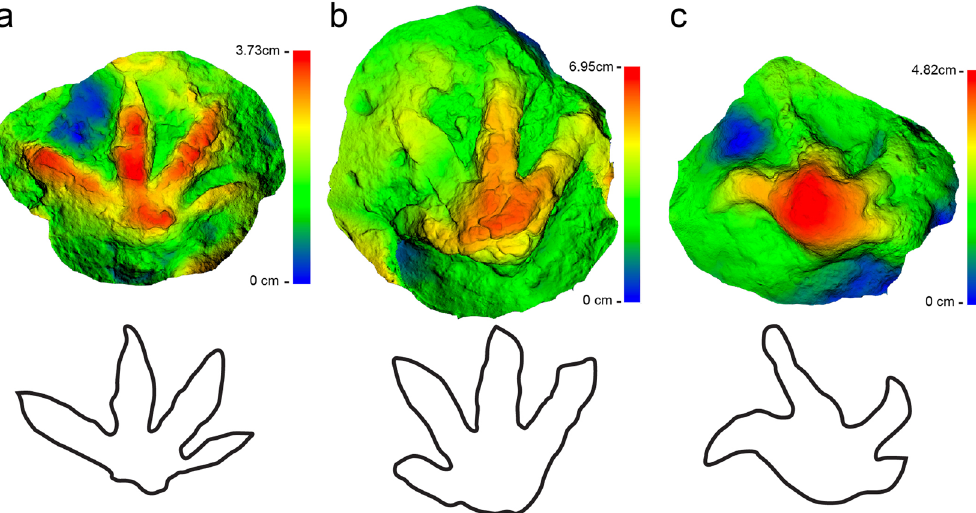
Figure 8. Digital elevation maps of three additional tracks from study area that illustrate the variation in the morphology of these therizinosaurid tracks. ( a ) DMNH 2013-08-04; ( b ) DMNH 2013-08-06; ( c ) DMNH 2014- 11-05.